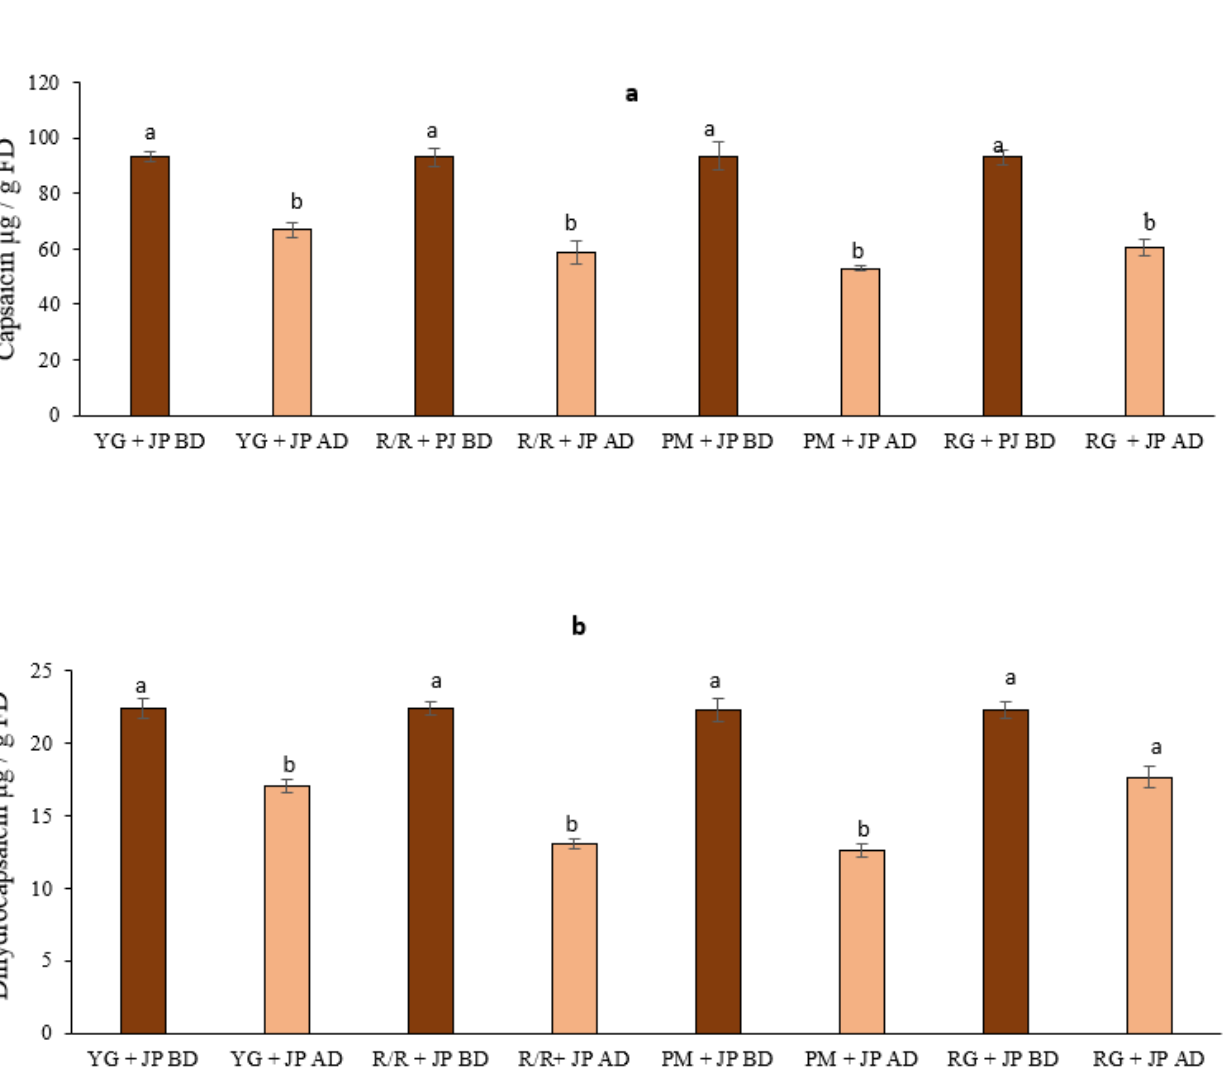
Figure 5. The levels of capsaicin and bioaccessibility of capsaicin of cooked potato cultivars mixed with roasted JP ( a ) and the levels of dihydrocapsaicin and bioaccessibility of dihydrocapsaicin of cooked potato cultivars mixed with roasted JP ( b ). Data are the mean of three replicates with standard deviation and are expressed as per gram off freeze-dried weight. Significant differences are denoted by different letters, while the same or shared letters indicate that they are not significant to each other. BD and AD: before and after digestion.